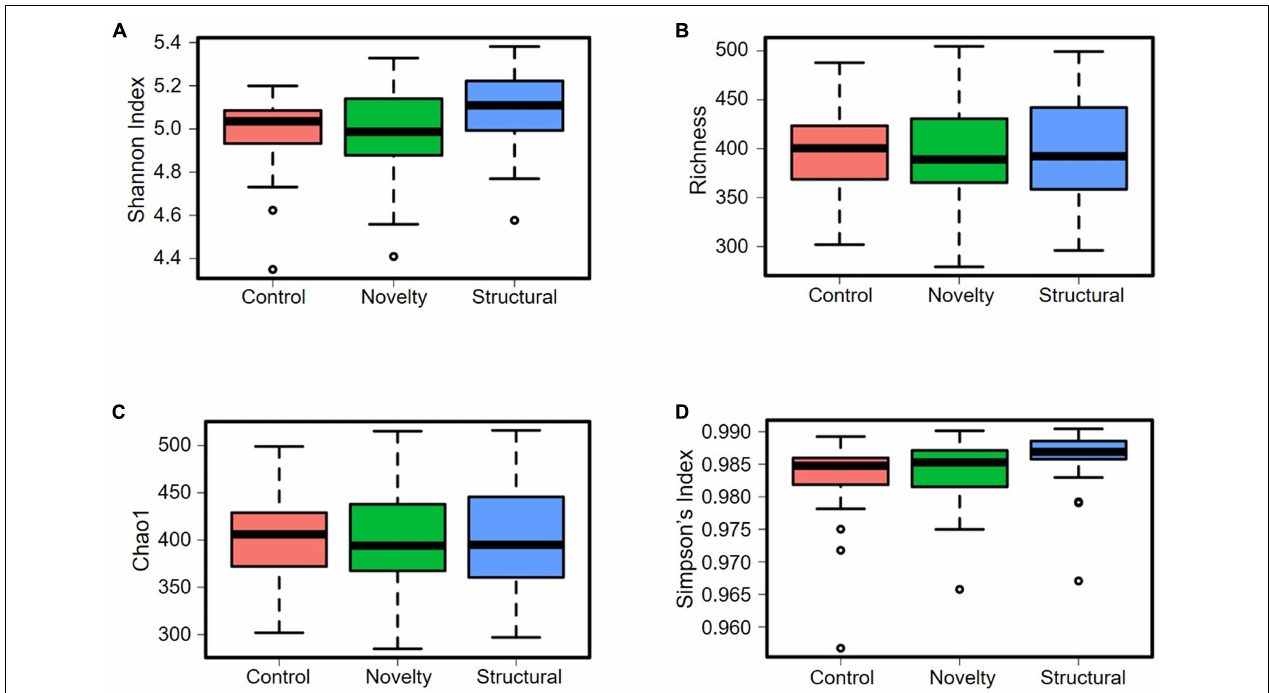
FIGURE 8 | Microbial diversity (alpha-diversity) of cecal microbiota of free-range hens at 65 weeks of age from different rearing enrichments (control, novelty, structural) at ASV level. (A) Shannon index, P = 0.07; (B) Richness, P = 0.74; (C) Chao1, P = 0.72; (D) Simpson’s index, P = 0.07.